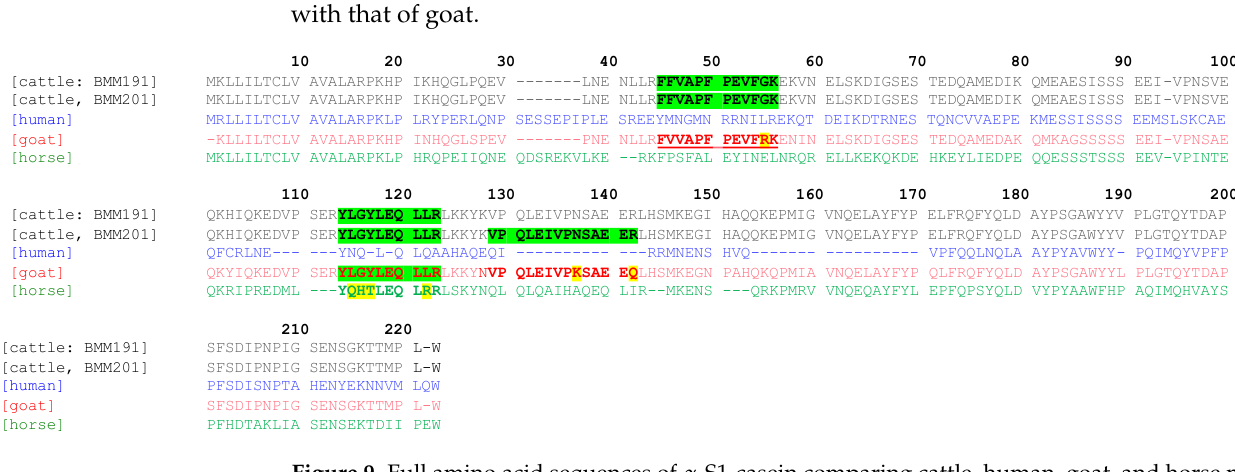
Figure 9. Full amino acid sequences of α -S1-casein comparing cattle, human, goat, and horse milk. Amino acid sequences of peptides identified by ESI-MS/MS are printed in bold face and highlighted in green. Color representing the sequence of each animal species: black (cattle); blue (human); red (goats); green (horse).